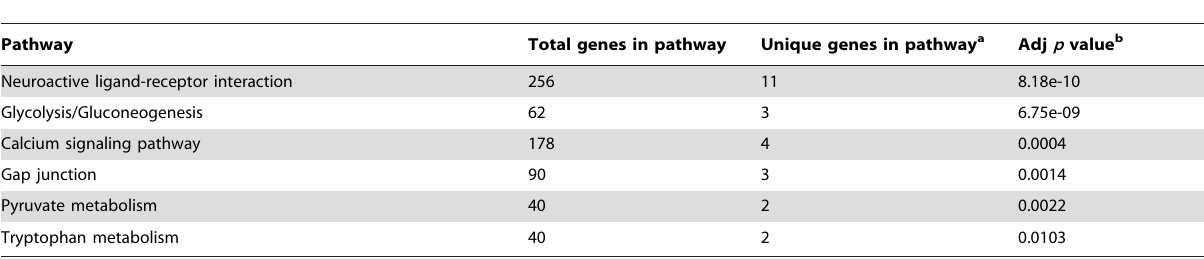
Table 3. Enriched regulated (KEGG) biological pathways among unique genes in healthy tissues.